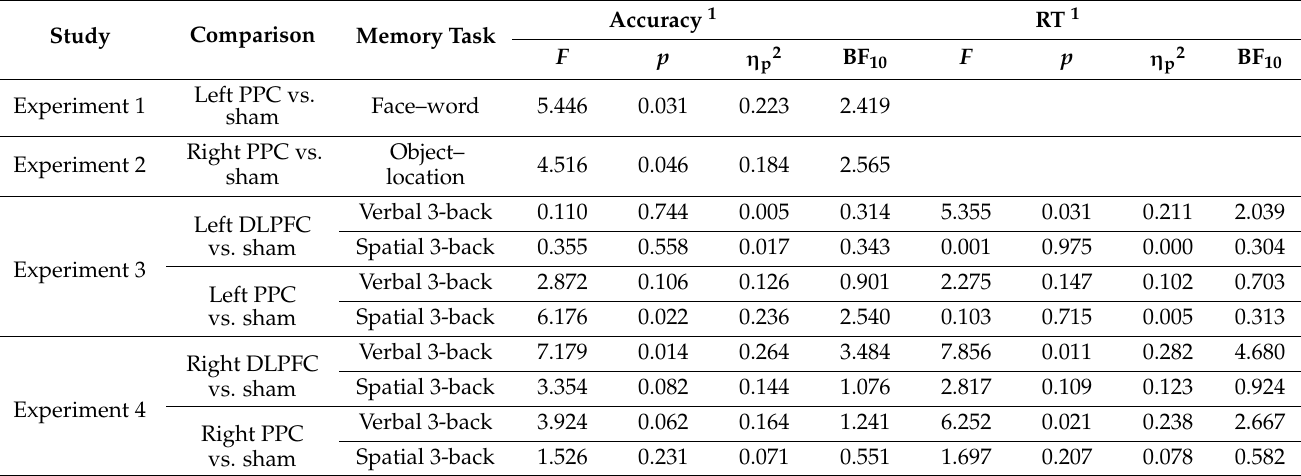
Table A1. tDCS effects on memory performance (Experiments 1–4).